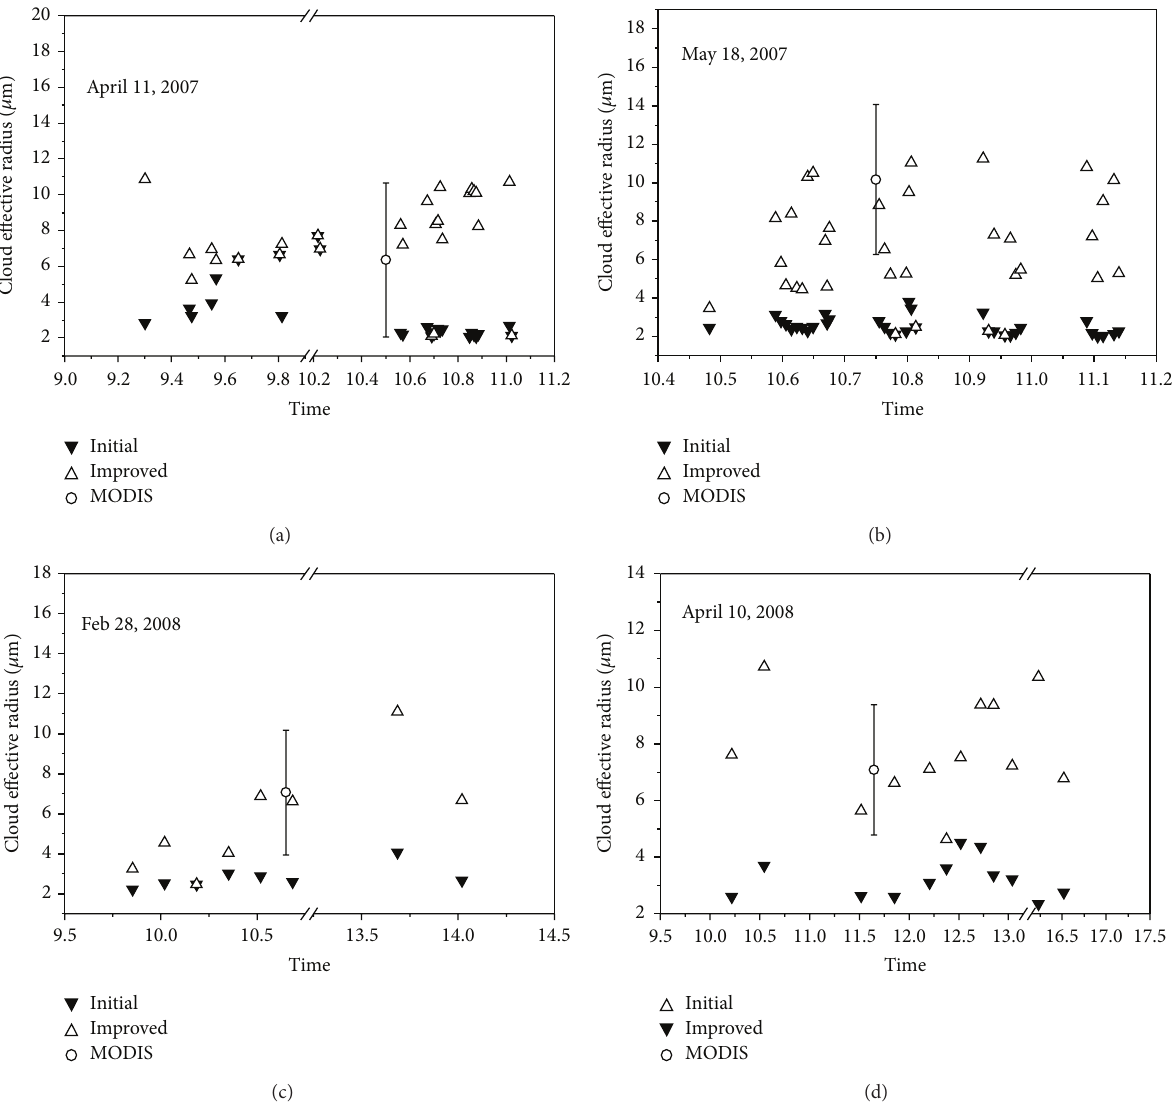
Figure 7: Initial, improved and satellite derived cloud droplet effective radius for Chiba (11 April and 18 May, 2007) and Cape Hedo (28 February and 10 April,